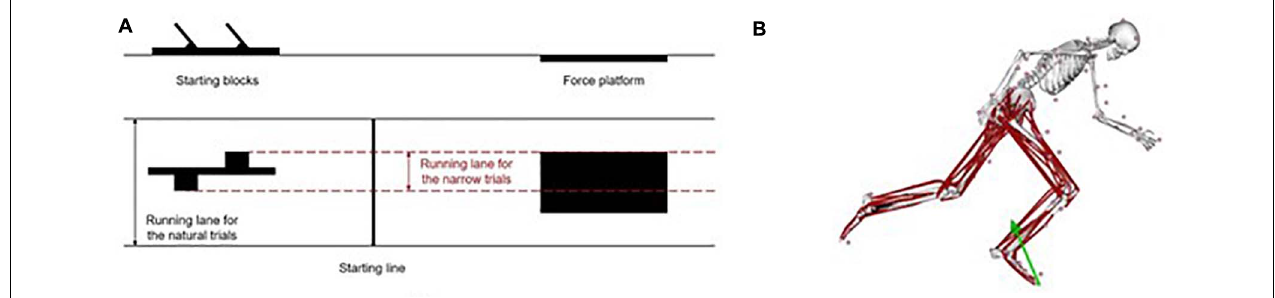
FIGURE 1 | (A) Front (top) and top (bottom) views of the setup of the laboratory for the narrow trials. Solid black lines represent the whole running track surface and the dashed red lines represent the limits within the sprinter could run during the narrow trials. (B) Musculoskeletal model with 74 markers, 22 body segments and 80 Hill-type musculotendon actuators used during the simulations with OpenSim of the first stance phase of sprint running. The green arrow represents the GRF.